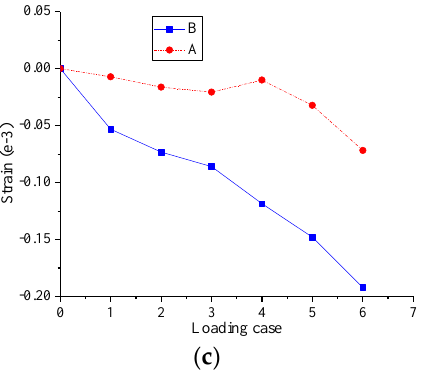
Figure 13. The maximum normal strain under each impact. ( a ) B/2 column base; ( b ) A/3 column base; and ( c ) the A end of the 2/A-B beam at the first floor.